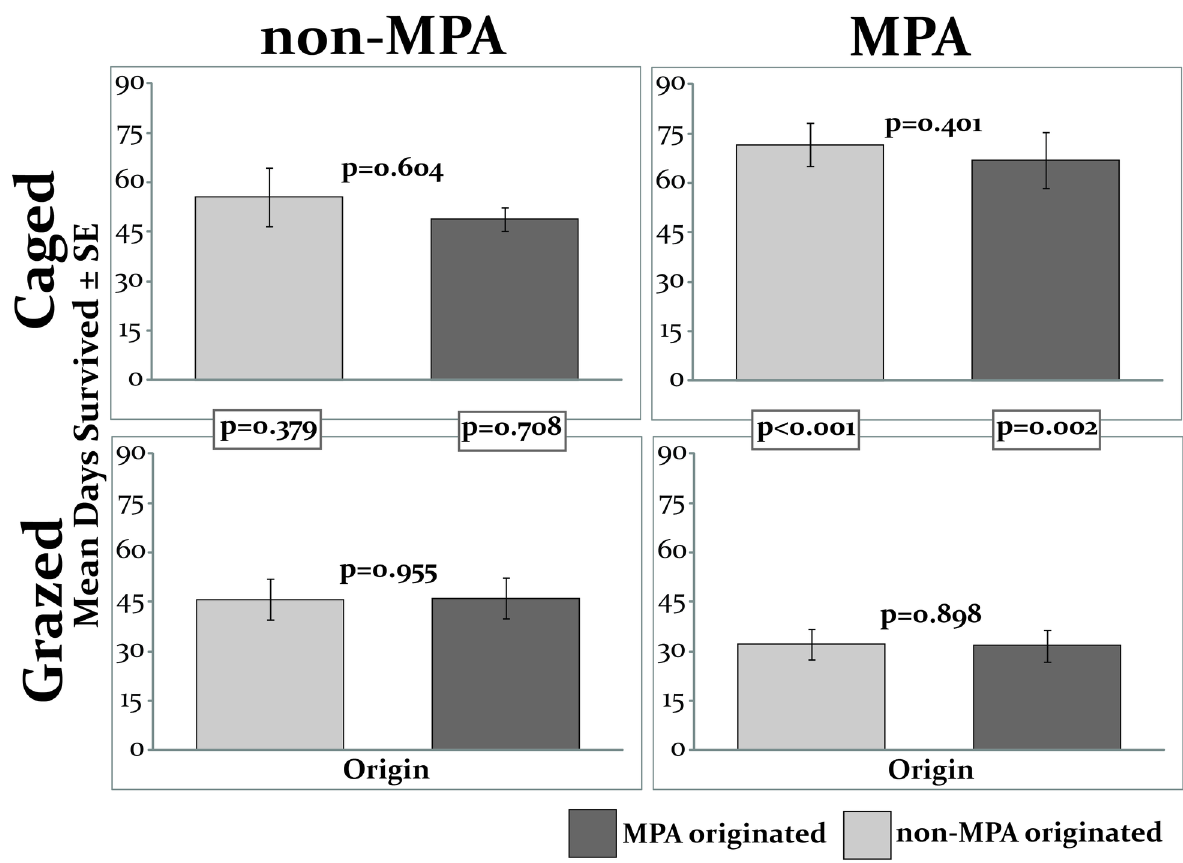
Fig 3. Survival of recruit-sized ramets reciprocally transplanted between MPA and non-MPA when caged or exposed. The experiment ran for 112 days; p-values above bars are from paired t-tests comparing the two origins within each treatment and location. Boxed p-values are from unpaired t-tests comparing ramets of the same origin in the caged and grazed treatments. N = 10 for each treatment and α = 0.025 to correct for multiple contrasts.